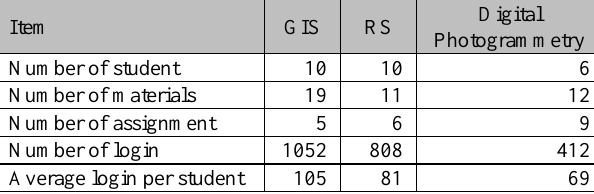
Table 2. Results of the three courses in the graduate